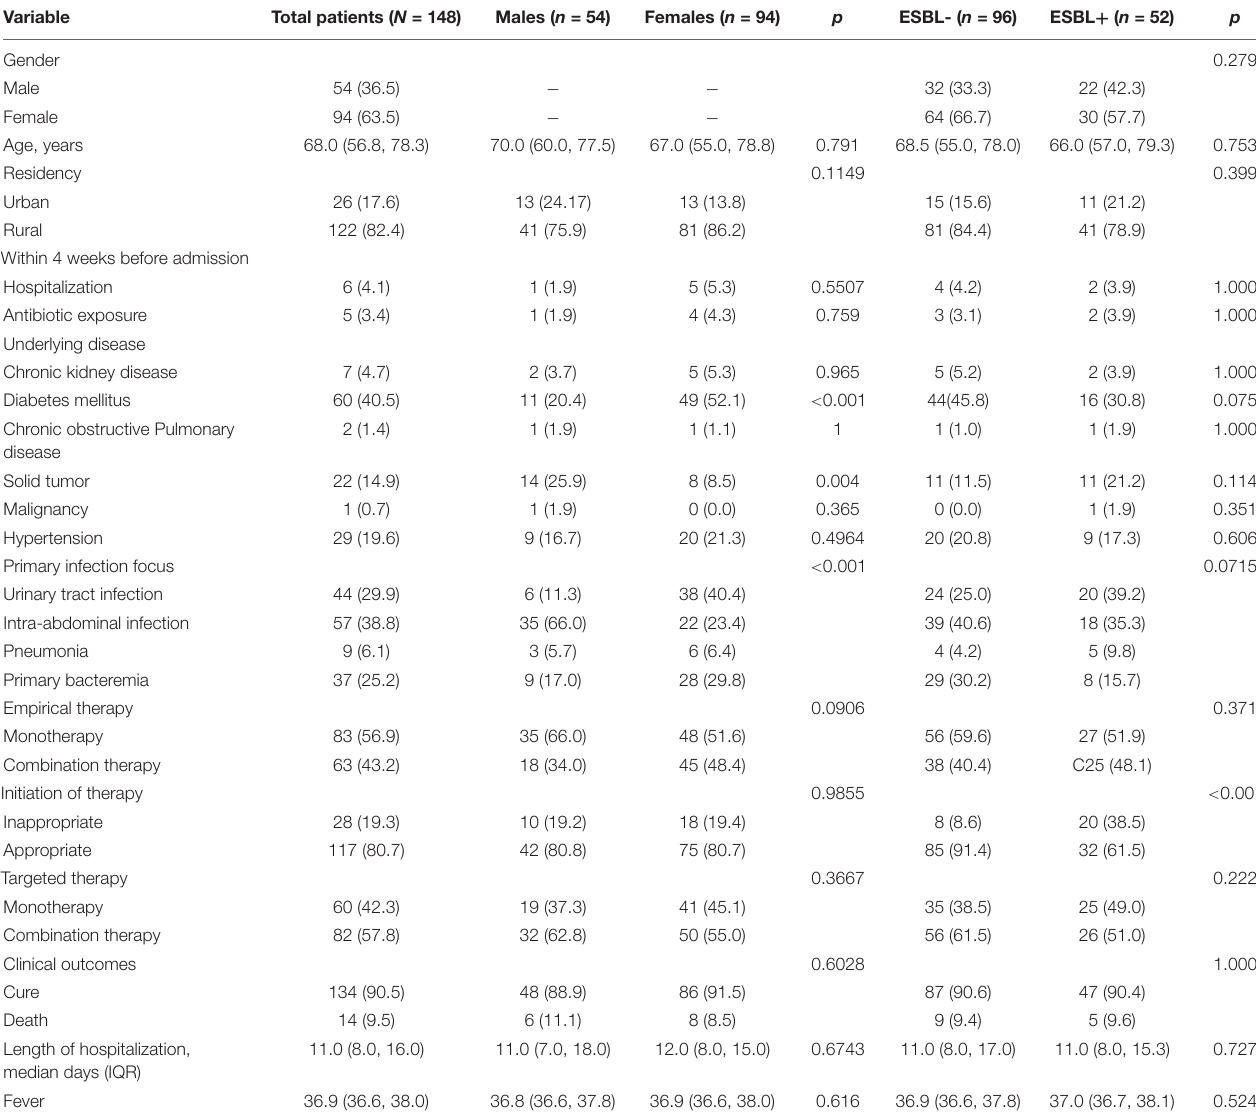
TABLE 1 | Demographic and clinical characteristics of patients with E. coli community-onset bacteremia.